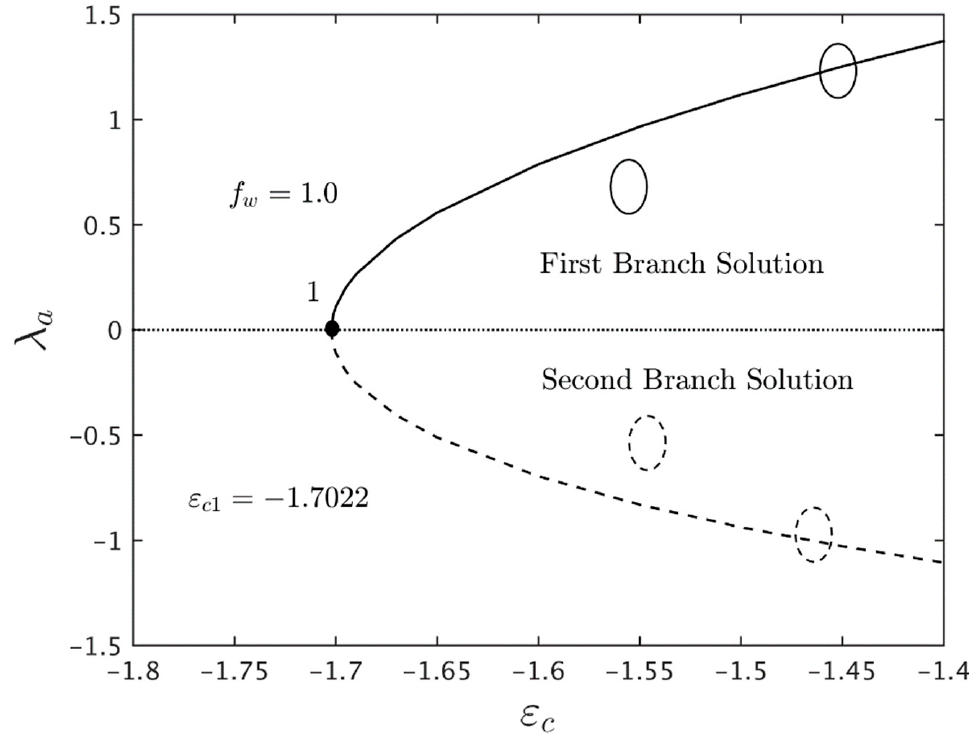
Figure 17. Eigenvalue 